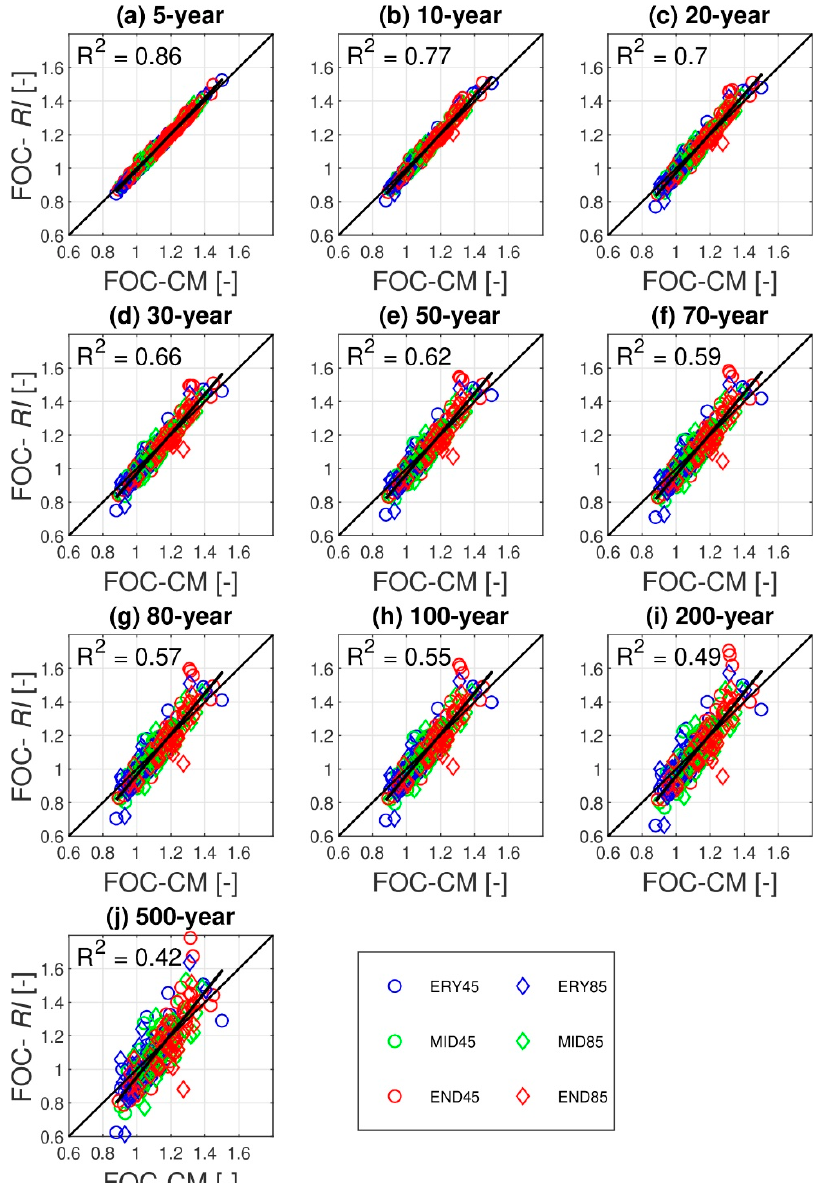
Figure 10. Comparisons between the factor of change of climatological mean (FOC-CM) of hourly maximum precipitation with the factor of change of rainfall frequency estimates (FOC- RI ) for 1-h duration for 10 return periods. The number of data points is 240 for the subplot (40 locations × 6 comparing periods). The R 2 values are computed for the 1:1 line. ERY45, MID45, and END45 are future periods (ERY, MID, and END) with RCP 4.5, respectively. The similarity is for RCP 8.5.